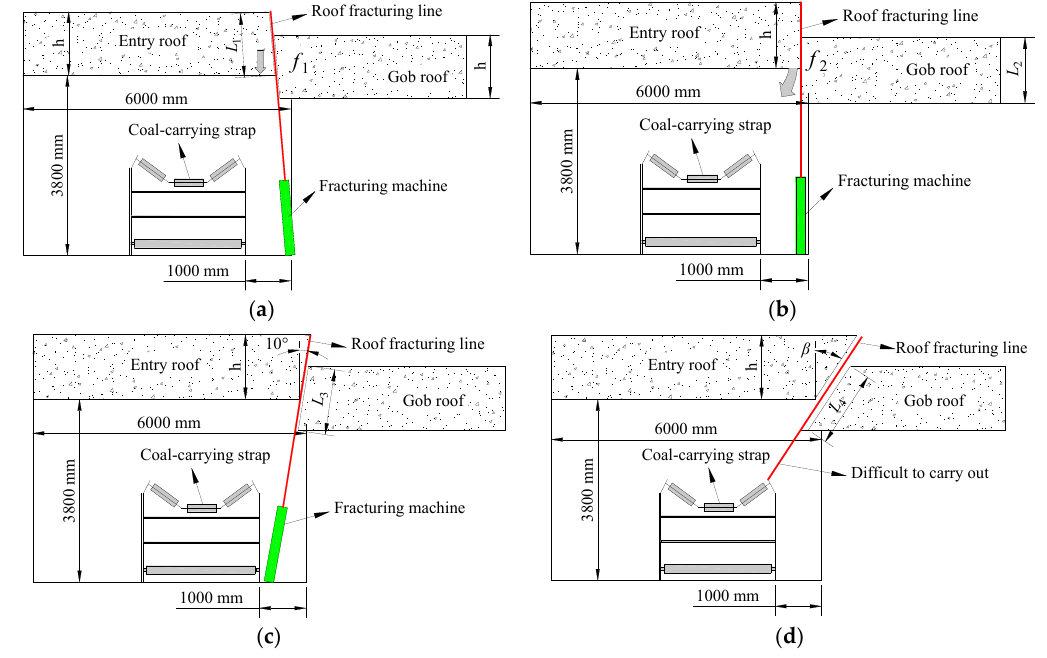
Figure 12. Roof fracturing direction design: ( a ) The fracturing direction points to the entry roof; ( b ) The fracturing direction is perpendicular to the entry roof; ( c ) Rational fracturing direction for the S1201 headentry; ( d ) The fracturing angle is too